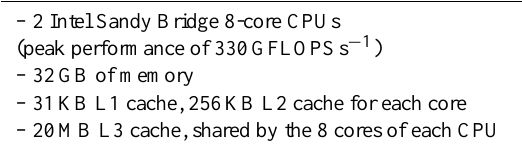
Figure 16. Ghost, boundary and interior cells for zonal (left) and meridional (right) advection.